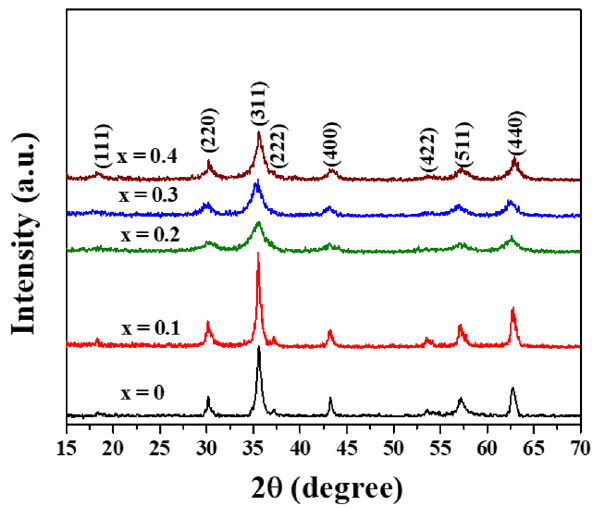
Figure 2. XRD patterns of Co x Zn 1−x Fe 2 O 4 (x = 0.0–0.4)